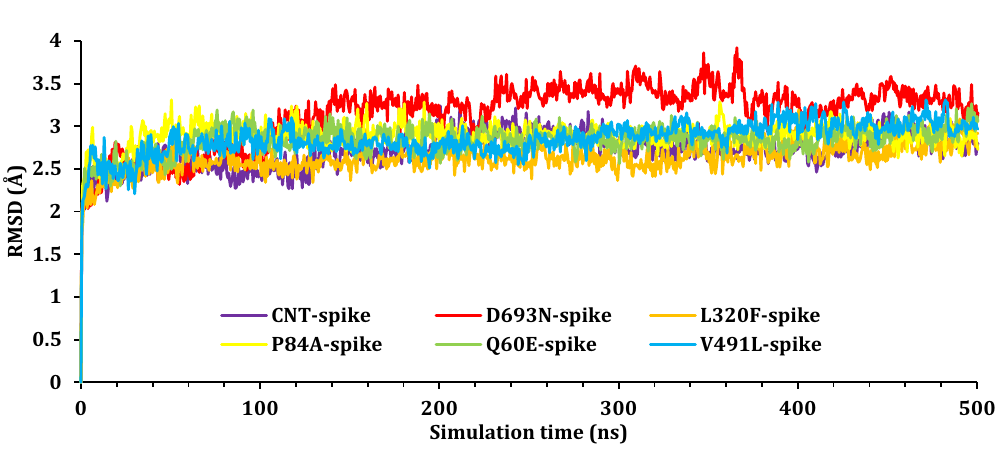
Figure 7. The RMSD for Cα atoms (Å) with respect to the initial structure as a function of simulation time (ns) for the SARS-CoV-2 spike protein.